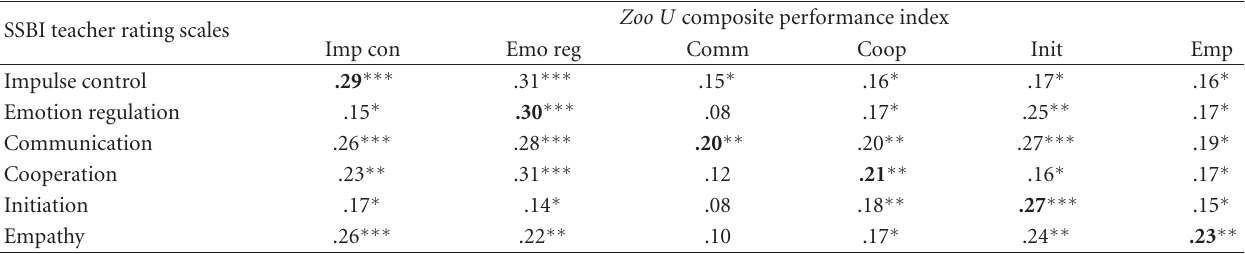
Table 2: Correlations between Zoo U composite performance and teacher ratings of student social skills.